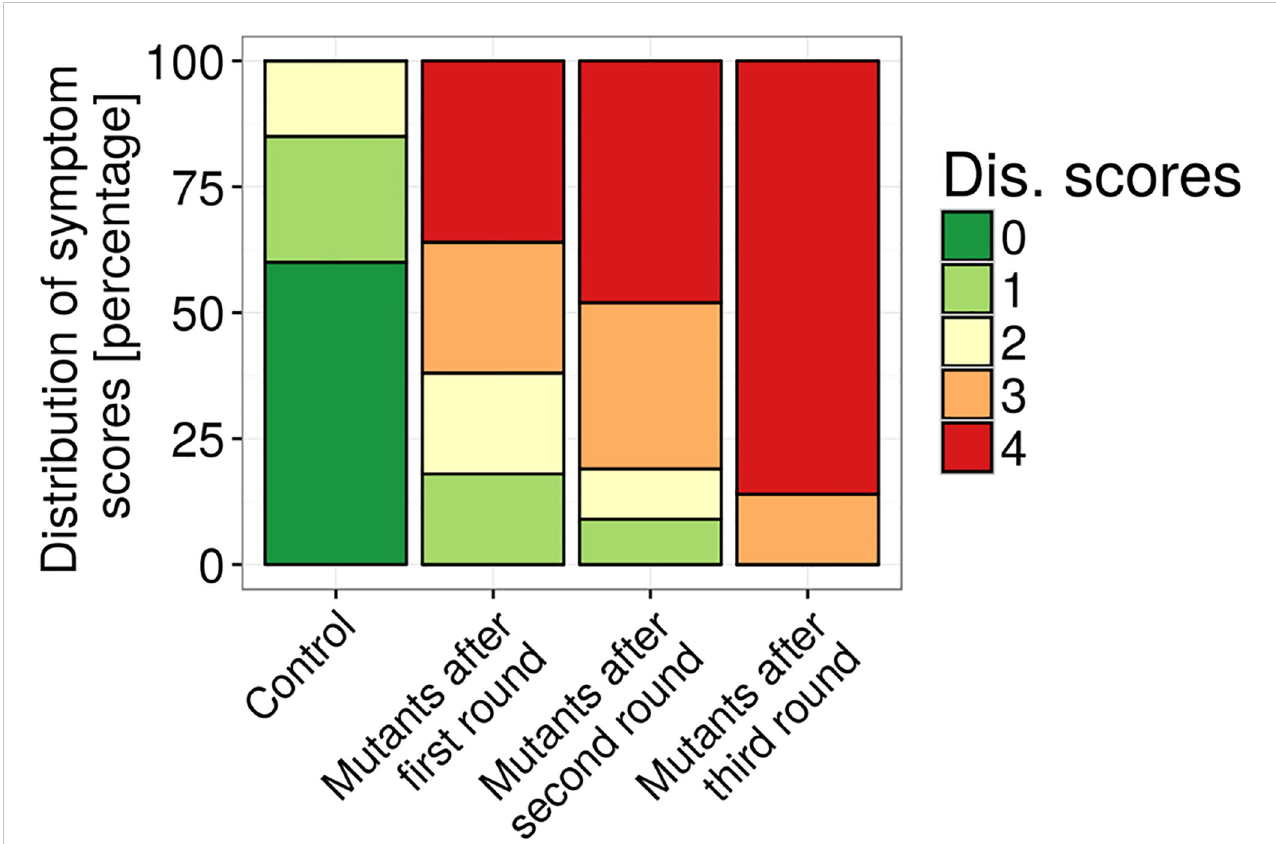
FIGURE 3 Aggressiveness of V. alfalfae V31-2 strains before and after successive steps of UV mutagenesis and in planta selection at 28°C. Plants of the susceptible line F83005.5 were root-inoculated and the symptom score after four weeks was determined, on a scale from 0 (healthy plant) to 4 (dead plant). One hundred fi fty plants were inoculated for each